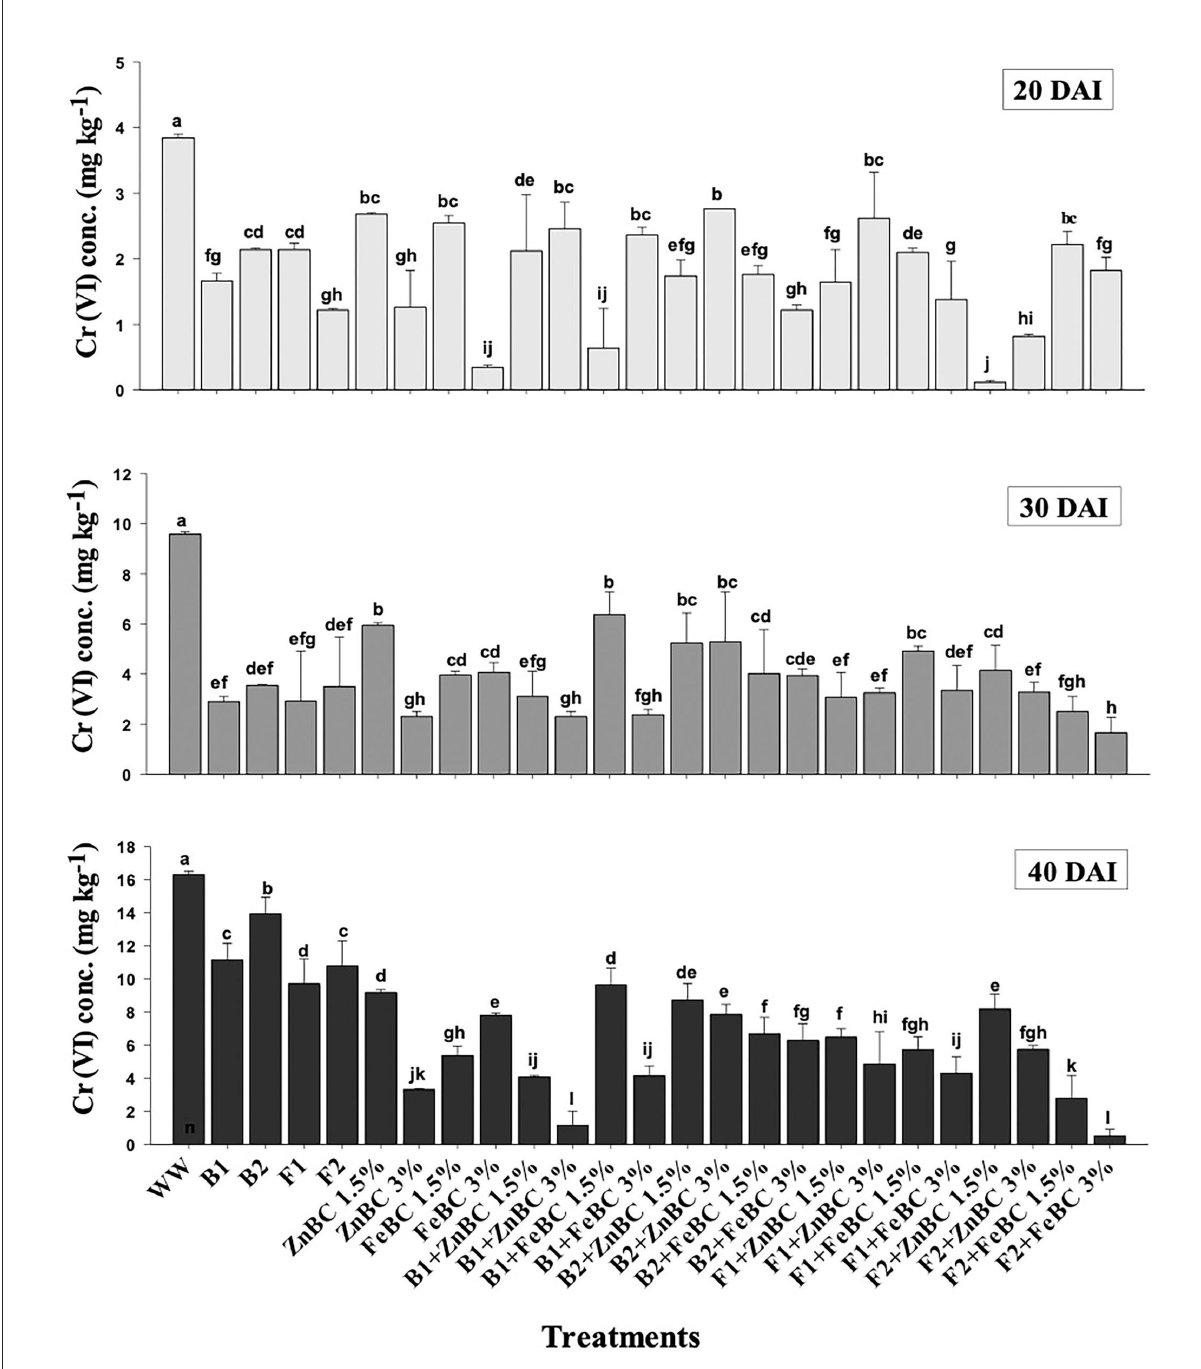
FIGURE4 DTPA-extractable Cr(VI) concentration (Mean ± S.D) for ZnBC (1.5, 3%) and FeBC (1.5 and 3%) treatments at 20, 30, and 40 DAI periodic assessments.